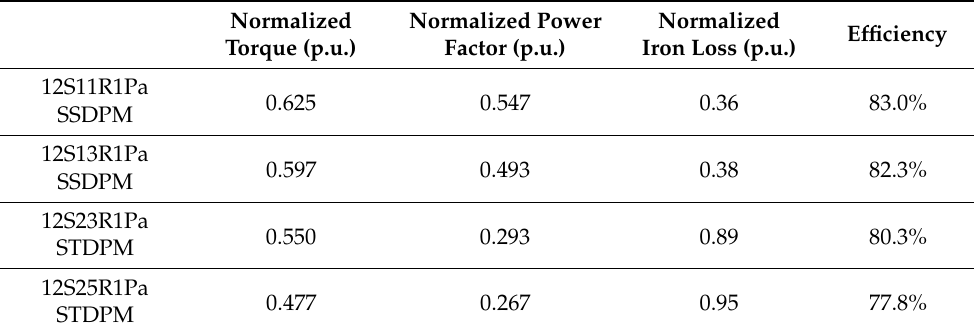
Table 4. Comparison of electromagnetic performances with a different rotor slot number selection under 600 rpm and the same copper loss.